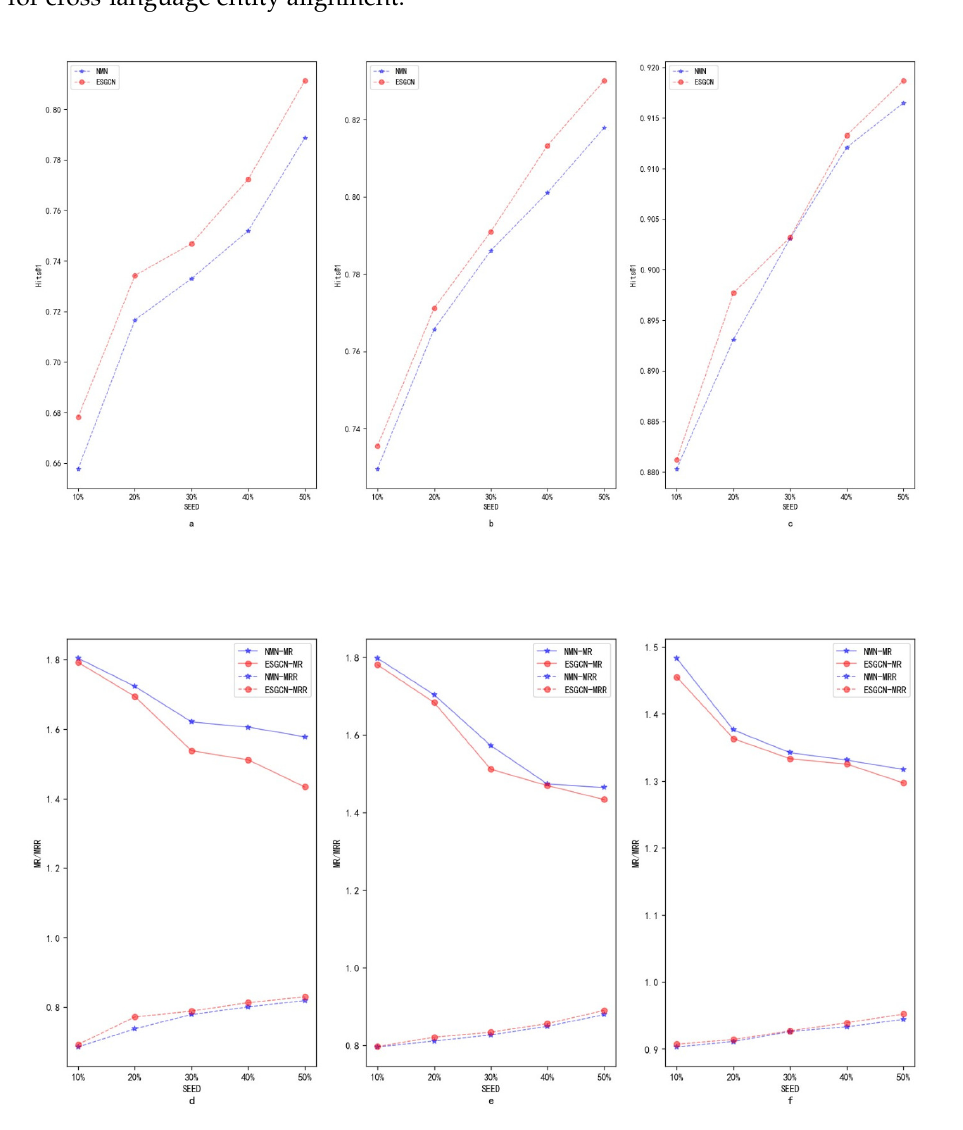
Figure 11. Performance comparison of the ESGCN and the NMN under different ratios of SEED. ( a ) ZH-EN ( b ) JA-EN ( c ) FR-EN ( d ) ZH-EN ( e ) JA-EN ( f )